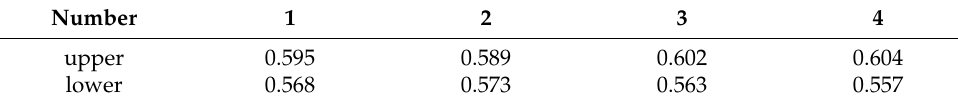
Figure 5. LJWF-DMD thin-walled parts. ( a ) Parts formed using various values of K . ( b ) Height measurement. ( c ) Thin-walled part inclined towards the Y -axis. ( d ) Measuring points. ( e ) Thickness measurement. ( f ) Thin-walled part inclined towards the X -axis. Table 3. The 150-layer thin-walled part thickness measurements (in mm), K = 1.